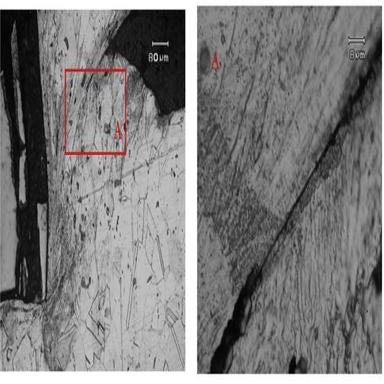
Chip fracture at different cutting speeds.